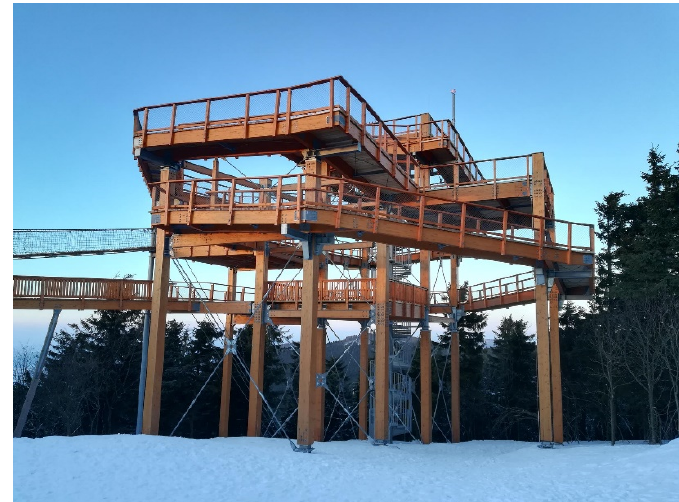
Figure 1. Example of a timber structure with bolted connections.